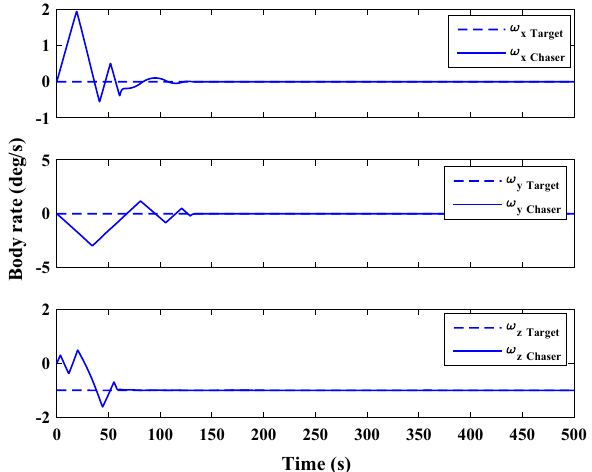
Figure 52. Scenario III: angular velocity tracking.